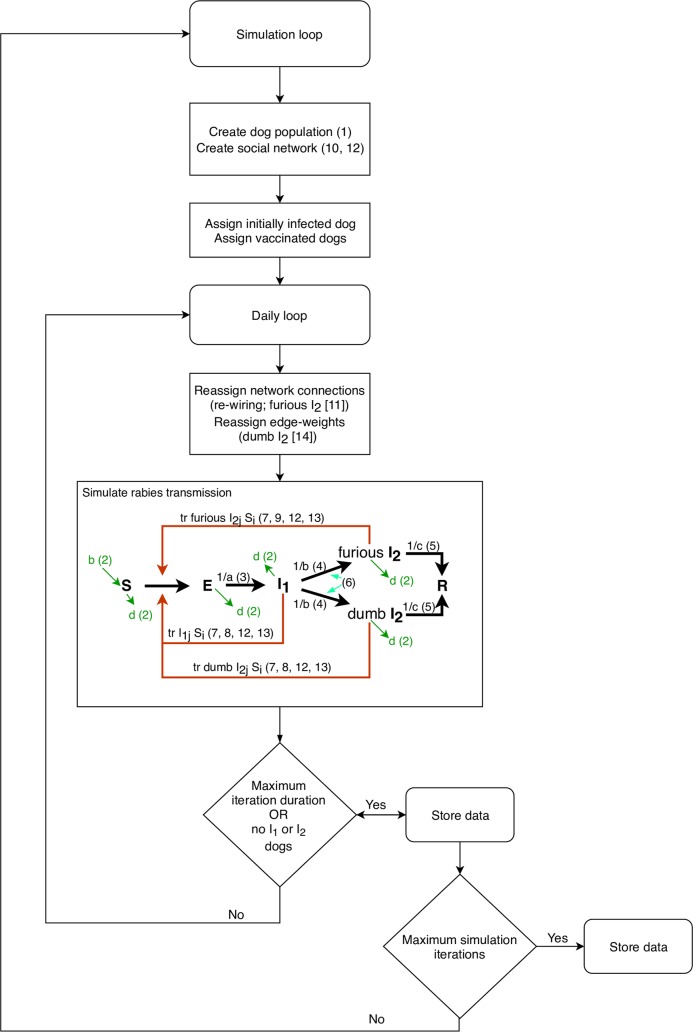
Process diagram of agent-based rabies spread simulation model in a population of dogs.S = susceptible state, E = latently infected state, I1 = pre-clinical infectious state, I2 = clinical state, R = dead state, tr = transmission, b = births, d = deaths, a = incubation period, b = pre-clinical infectious period, c = clinical period, j = individual infectious dog, i = individual susceptible dog. Numbers in parentheses are references to parameter values in Table 2.